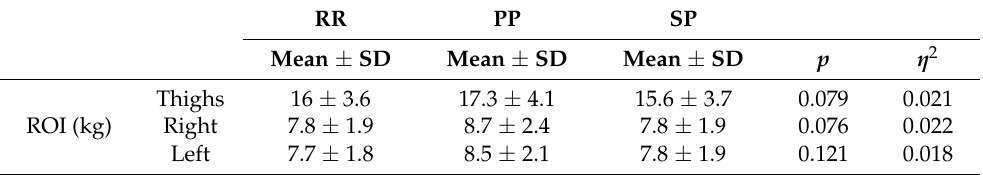
Table 3. Lean mass (kg) of the ROIs as a function of EM type.